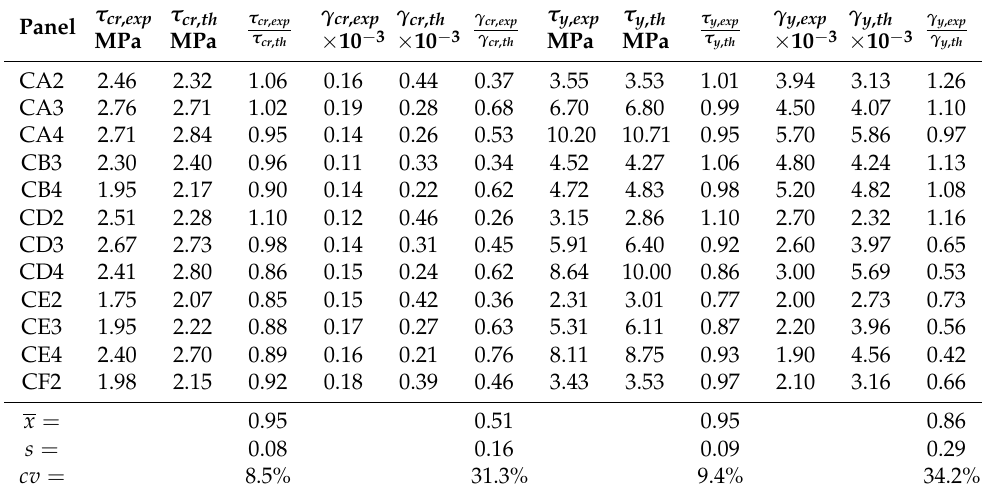
Figure 8. Drawing the experimental envelope curve from the hysteretic loops. Table 2. Comparative analysis: positive (+) loading shear direction (cracking and yielding points). τ cr , exp Panel